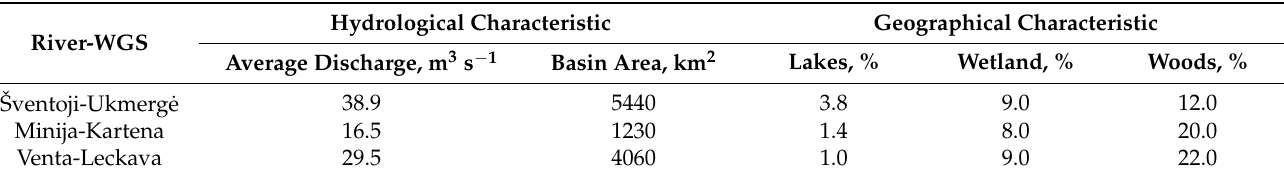
Table 2. Main characteristics of the selected river catchments.